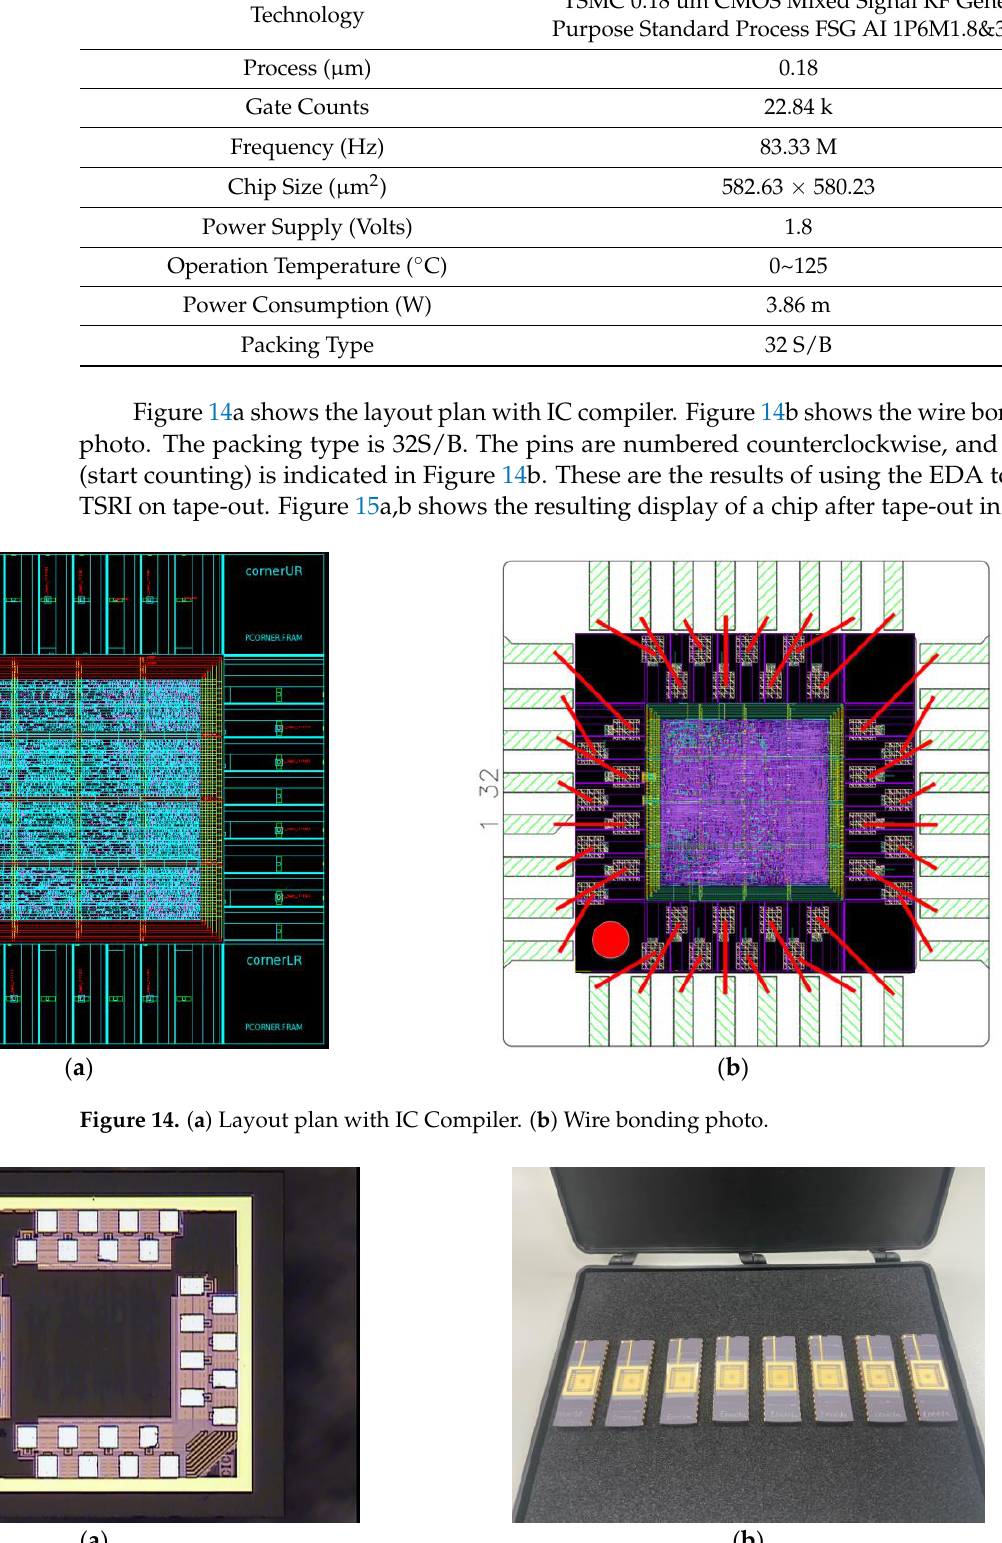
Table 8. Specification of Chip.